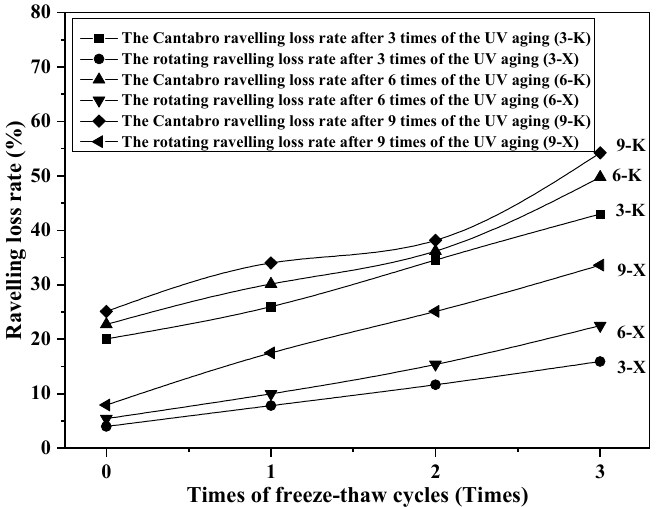
Figure 13. The results of the comparison between the two types of stripping tests under multi-factor influence.